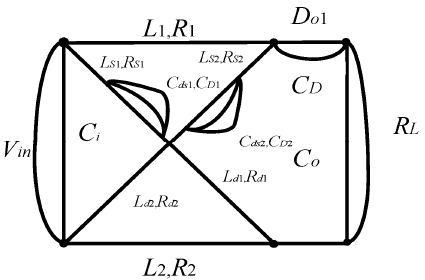
Figure 3. Undirected graph of dual-switch boost converter considering parasitic parameters.